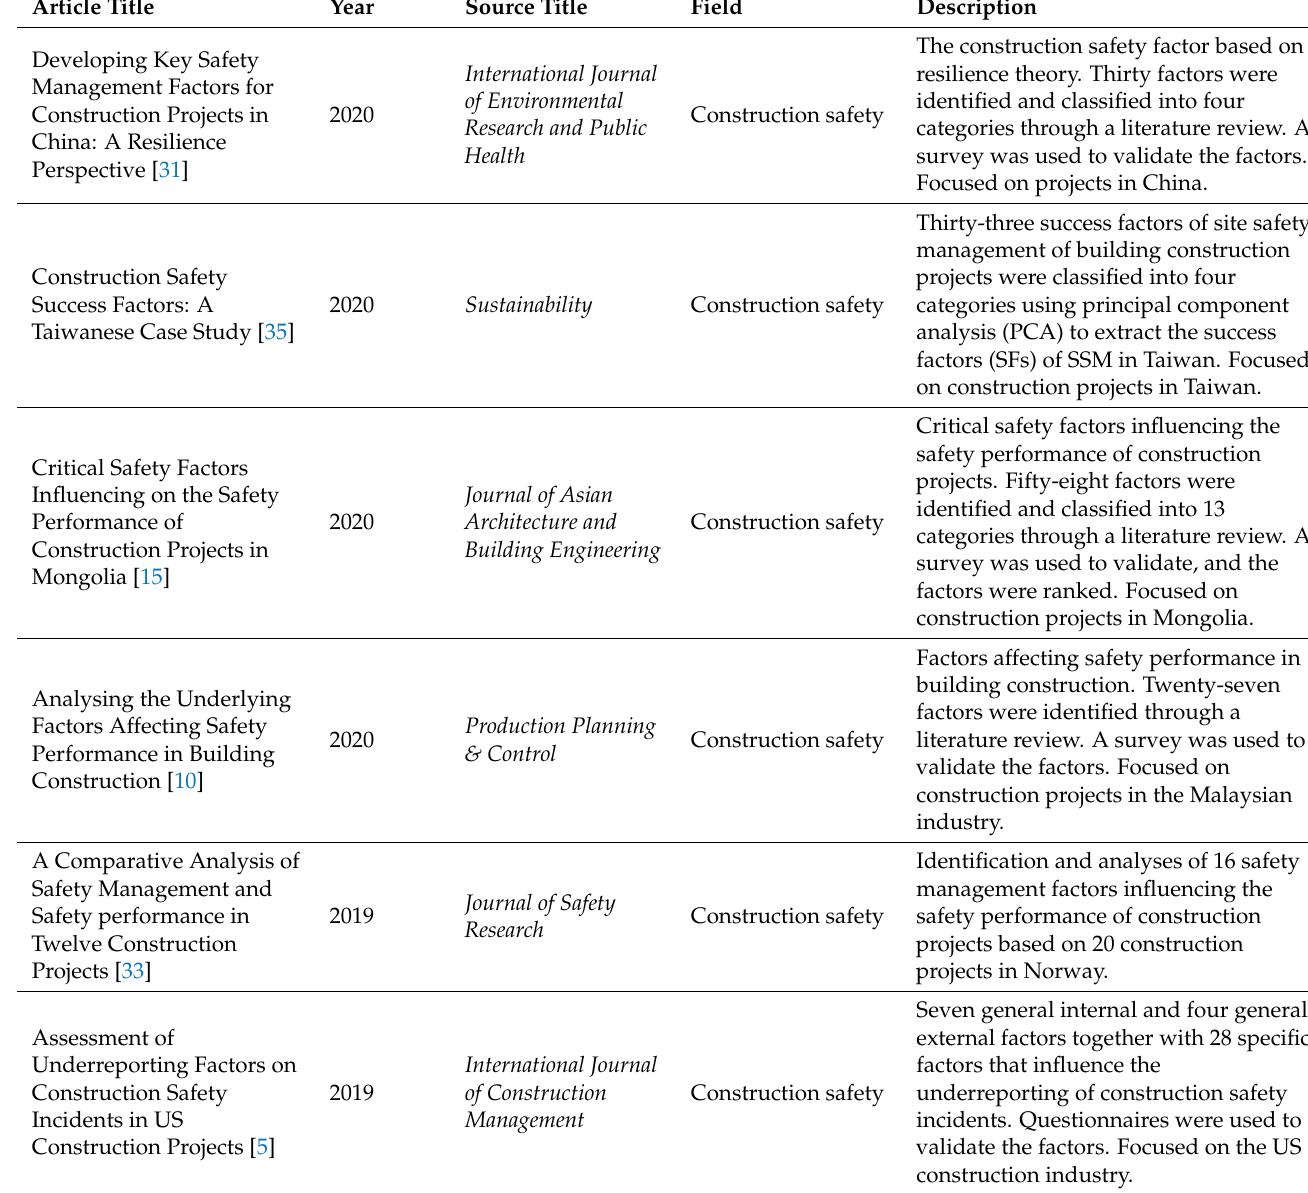
Table 1. Key articles’ title, year, source, field, study region and the